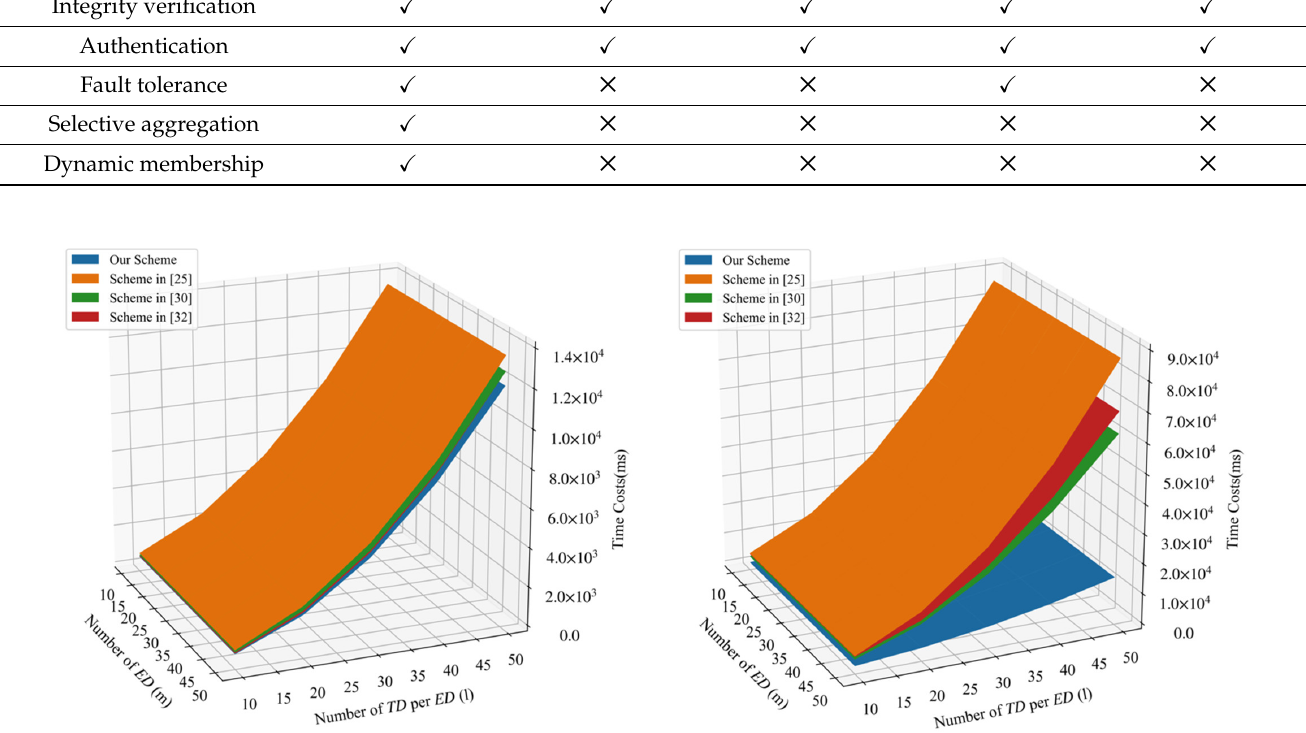
Figure 3. Comparison of overall computation costs.